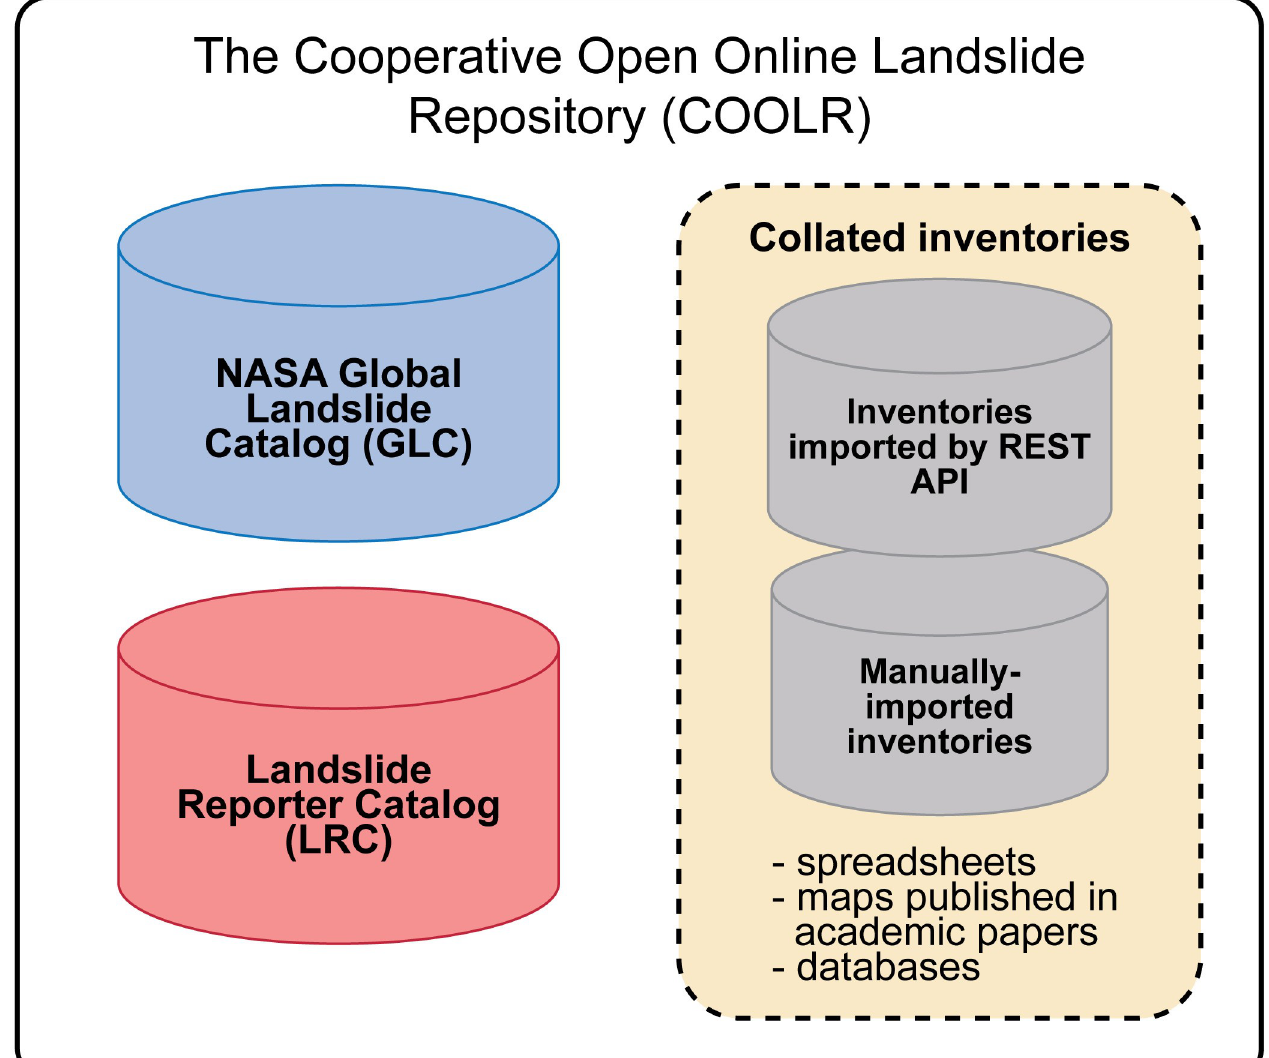
Fig 3. Cooperative Open Online Landslide Repository (COOLR) Components Schematic. The rectangle encompasses the sources of data within COOLR. The three sources are NASA’s Global Landslide Catalog (GLC), citizen scientist contributions through the Landslide Reporter Catalog (LRC), and collated inventories from landslide experts and other citizen science